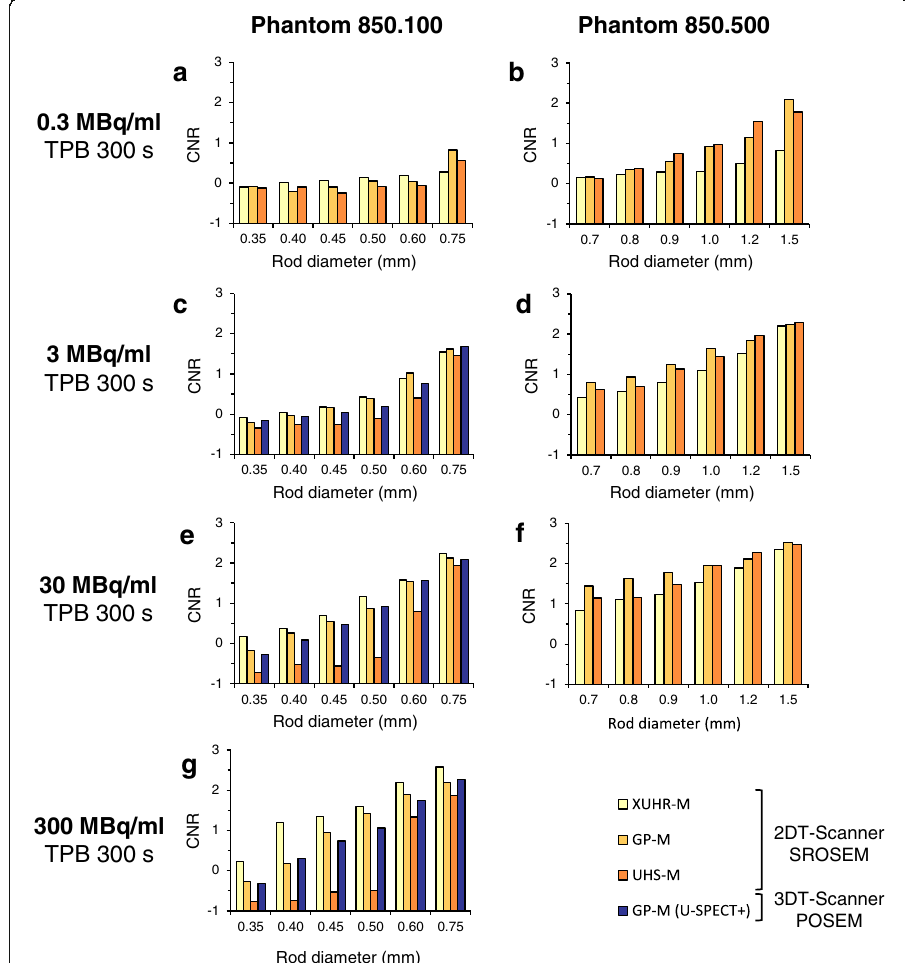
Fig. 4 Contrast-to-noise ratio (CNR) of the investigated collimators with optimized values for each rod size by Gaussian post-filtering (full width half maximum = rod size). Bar charts compare the image quality of the collimators XUHR-M, GP-M and UHS-M for different activity levels in the mini Derenzo phantoms 850.500 and 850.100. In addition, the graphs in ( c ), ( e ) and ( g ) show how the 3DT-Scanner with the same GP-M collimator and a pixel-based ordered-subset expectation maximisation (POSEM) reconstruction algorithm compares to the new 2DT-Scanner and the similarity-regulated ordered- subset expectation maximisation (SROSEM) algorithm. Time per bed position (TPB) was 300 s with at least 9 bed positions (BP), corresponding to a total scan duration of 45